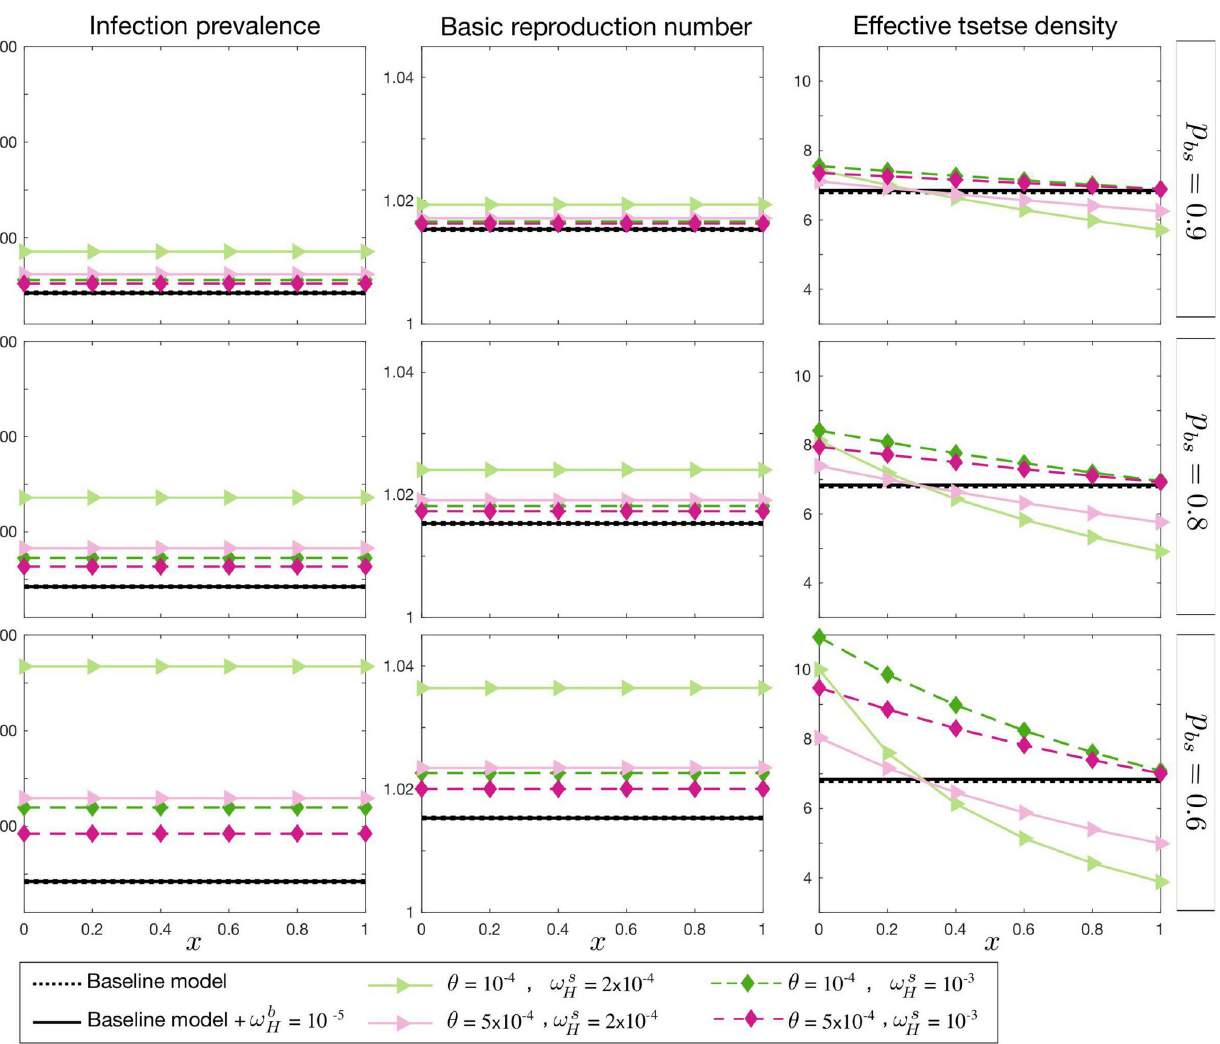
Fig 4. Endemic equilibrium with observable incidence u γ ( Y ) I 2 fixed. Total prevalence, I , the basic reproduction number R 0 , and the effective tsetse H H H density, m eff , are plotted as a function of x , the relative infectiousness of skin-only infections compared to blood infections. The proportion of blood to skin- only infections, p , is fixed for each row and different values of the self-curing skin-only infection rate, o s , and the skin-only to blood infection progression bs H rate, θ , are shown with various colours. There is no skin-only infection, p bs = 1, for the black lines; the dashed line represents the baseline model (with no asymptomatic components) and the solid line represents the baseline model but with the possibility of self cure from first-stage blood infection, I b , at a rate 1 H o b ¼ 10 (cid:0) 5 . The prevalence and incidence are given per 10,000 H